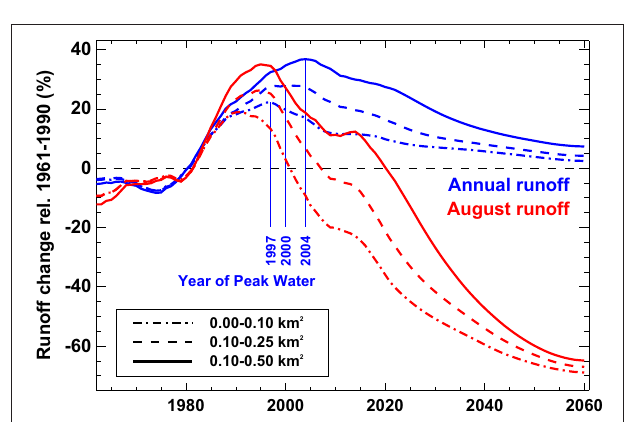
FIGURE 11 | Changes in annual and August runoff from very small glaciers relative to the period 1961–1990. Results are shown for three size classes and the A1B median scenario. The constant hydrological catchment of each glacier refers to the perimeter ice-covered by